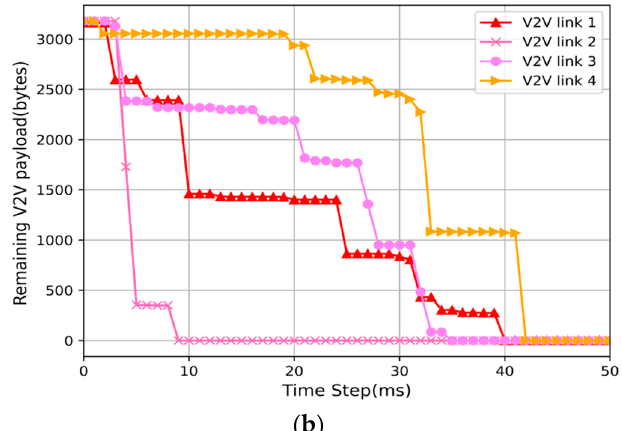
Figure 5. Remaining V2V payload comparisons between proposed and random schemes. ( a ) The remaining payload of the proposed. ( b ) The remaining payload of the random. Figure 6 reflects the impact of V2I power changes on V2I throughput and the proba ‐ bility of successful V2V link transmission. It can be seen that with the increase in V2I power, the throughput of the V2 link increases, and at the same time, the interference to the V2V links increases, so the probability of successful transmission of the V2V links decreases. Therefore, it is necessary to reasonably set the power of the V2I links to meet the throughput requirements of the V2I links and the delay requirements of the V2V links.